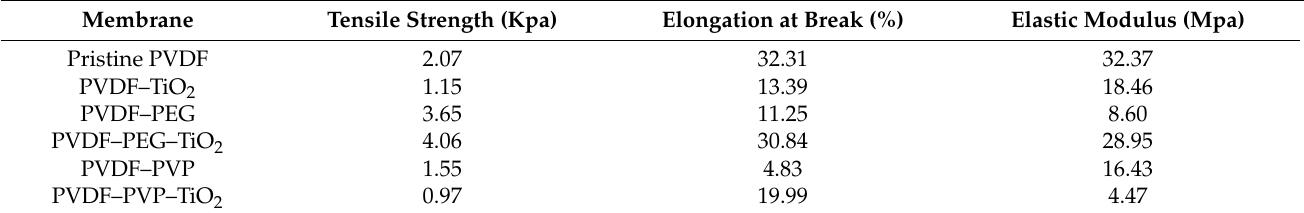
Table 4. Tensile test of membranes.